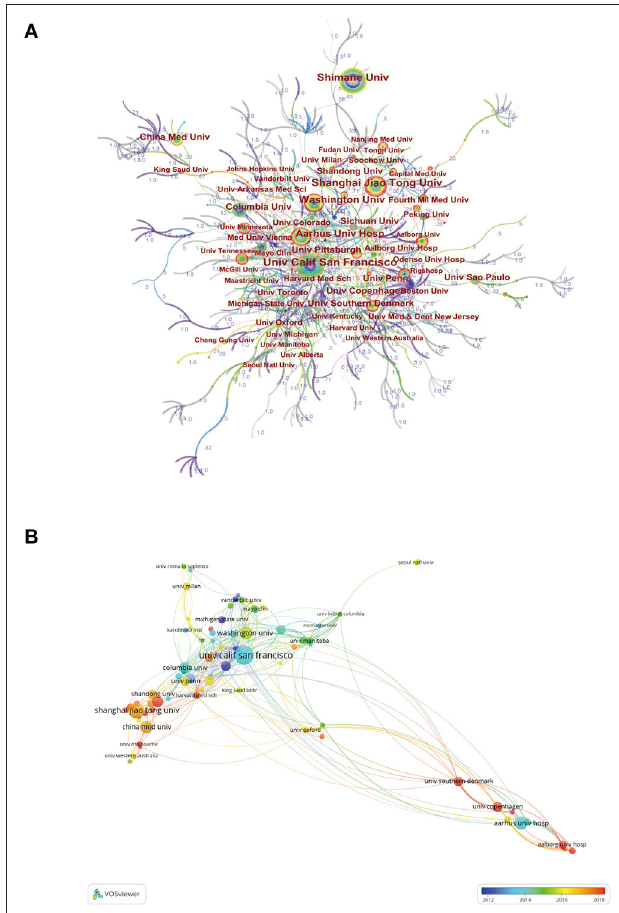
FIGURE 4 | (A) Network visualization map of institutional collaborations generated by CiteSpace. In this map, a node represents an institution, and the size of each node represents its relative quantity of research output. Each line represents the strength of the cooperation relationship between two institutions, and strength value is displayed between lines. (B) The overlay visualization map of Institution co-authorship analysis conducted by